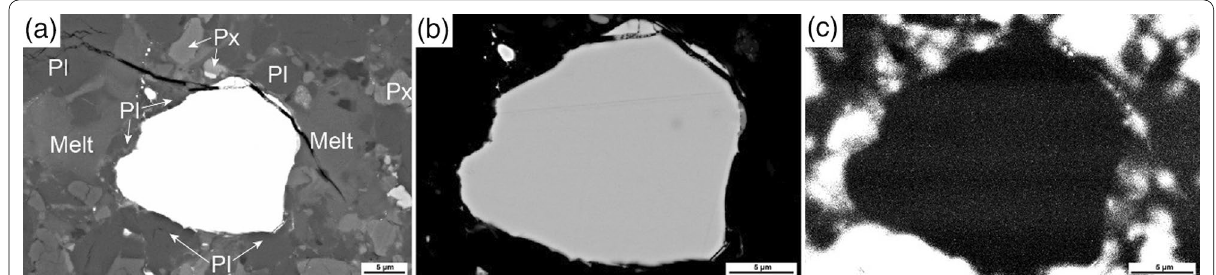
Fig. 1 The occurrence of zirconolite grain from NWA 4485. a BSE image of the zirconolite grain, occurring as a mineral fragment in matrix of the lunar regolith breccia. This grain is surrounded by plagioclase (Pl), pyroxene (Px), and silicate melts (Melt). b Contrast-enhanced backscattered image of the grain, showing a homogeneous composition. c The grain is dark in CL image, showing no trace elements heterogeneity or